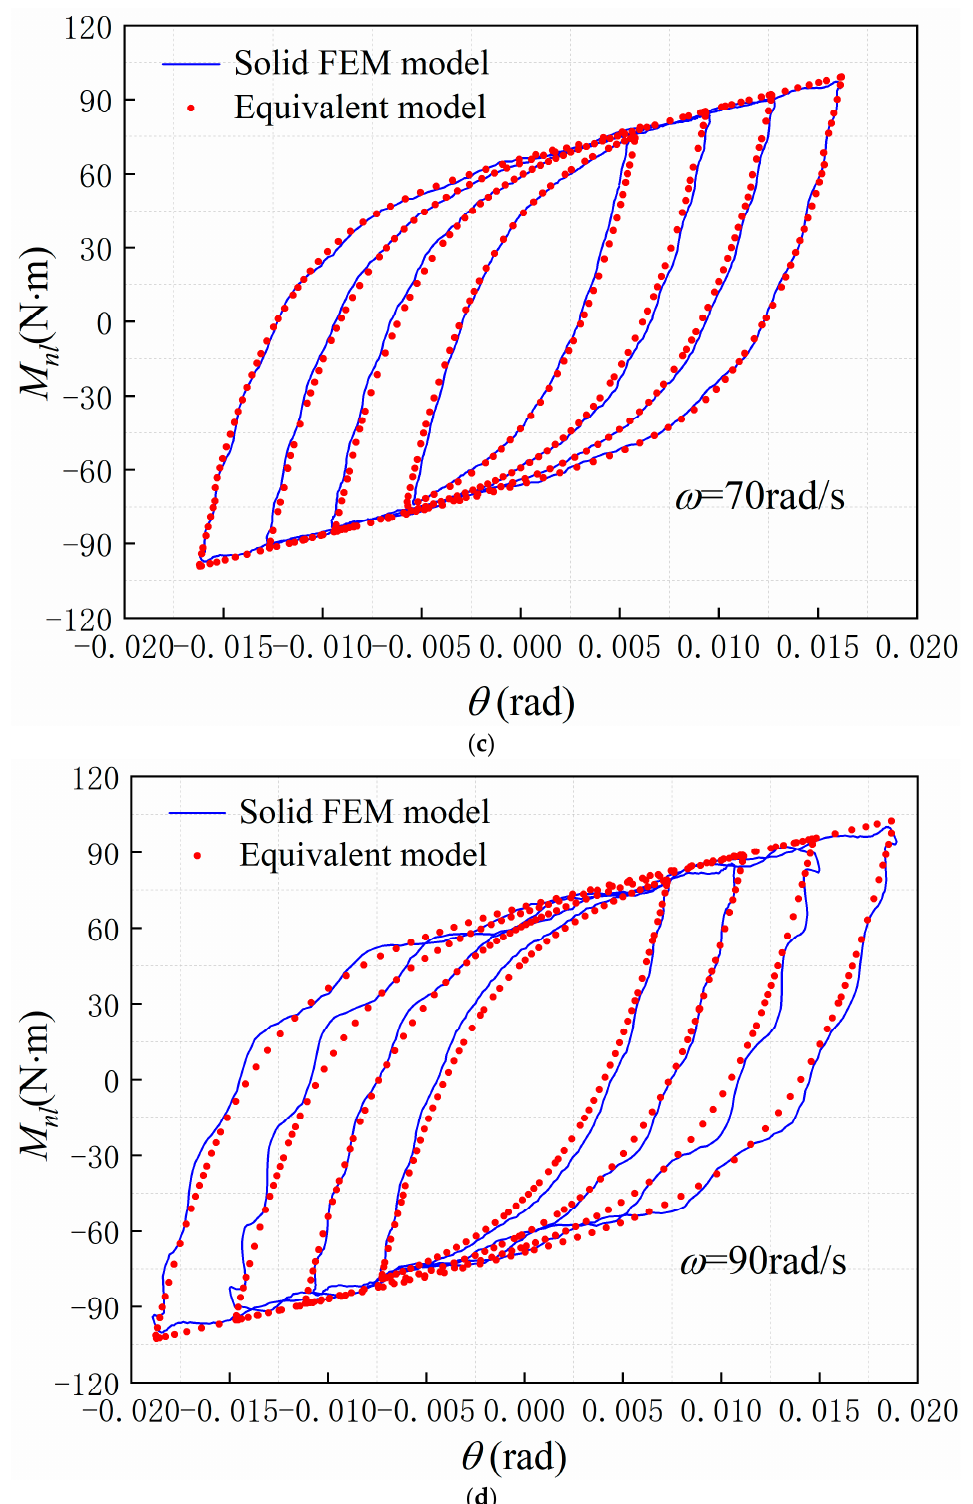
Figure 15. Hysteresis loops of the bolted joint under different excitation frequency: ( a ) ω = 30 rad/s; ( b ) ω = 50 rad/s; ( c ) ω = 70 rad/s; ( d ) ω = 90